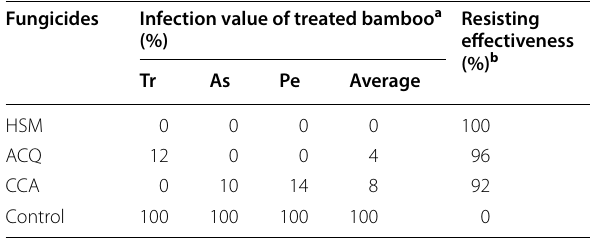
Table 2 Overall appraisal of the fungicides against the test